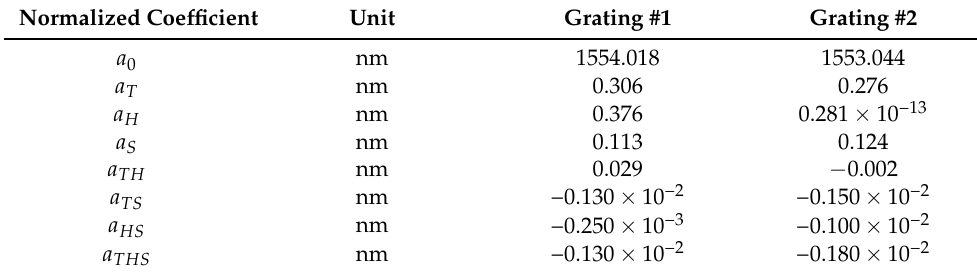
Table 5. Normalized main and cross sensitivities of FBG in CYTOP fiber with (Grating #1) and without over-clad (Grating